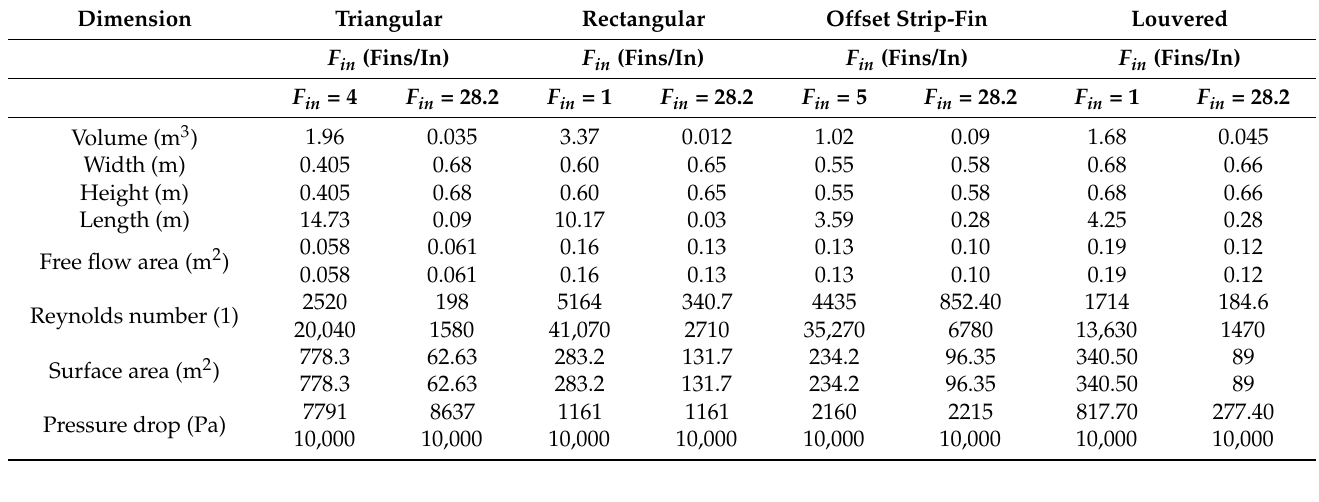
Table 7. Volume and block dimensions for the case study